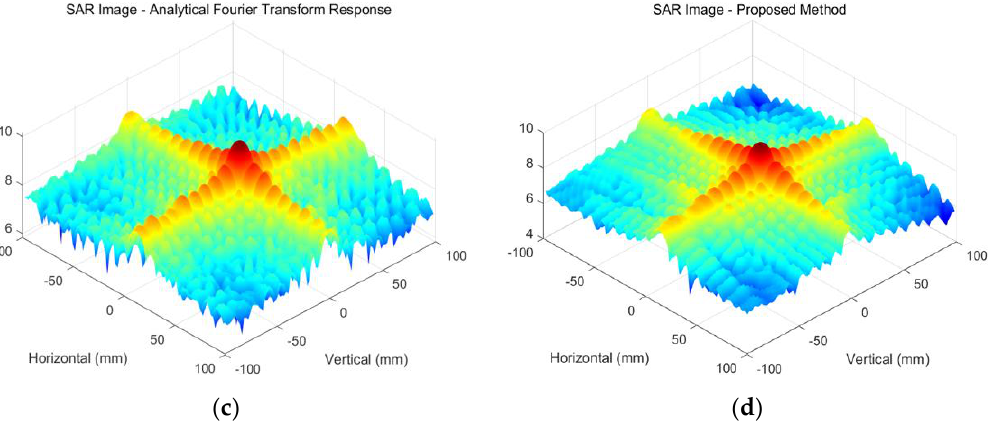
Figure 17. Point Spread Function: ( a ) Back Projection; ( b ) Matched Filter; ( c ) Analytic Fourier Transform; ( d ) mmSight.